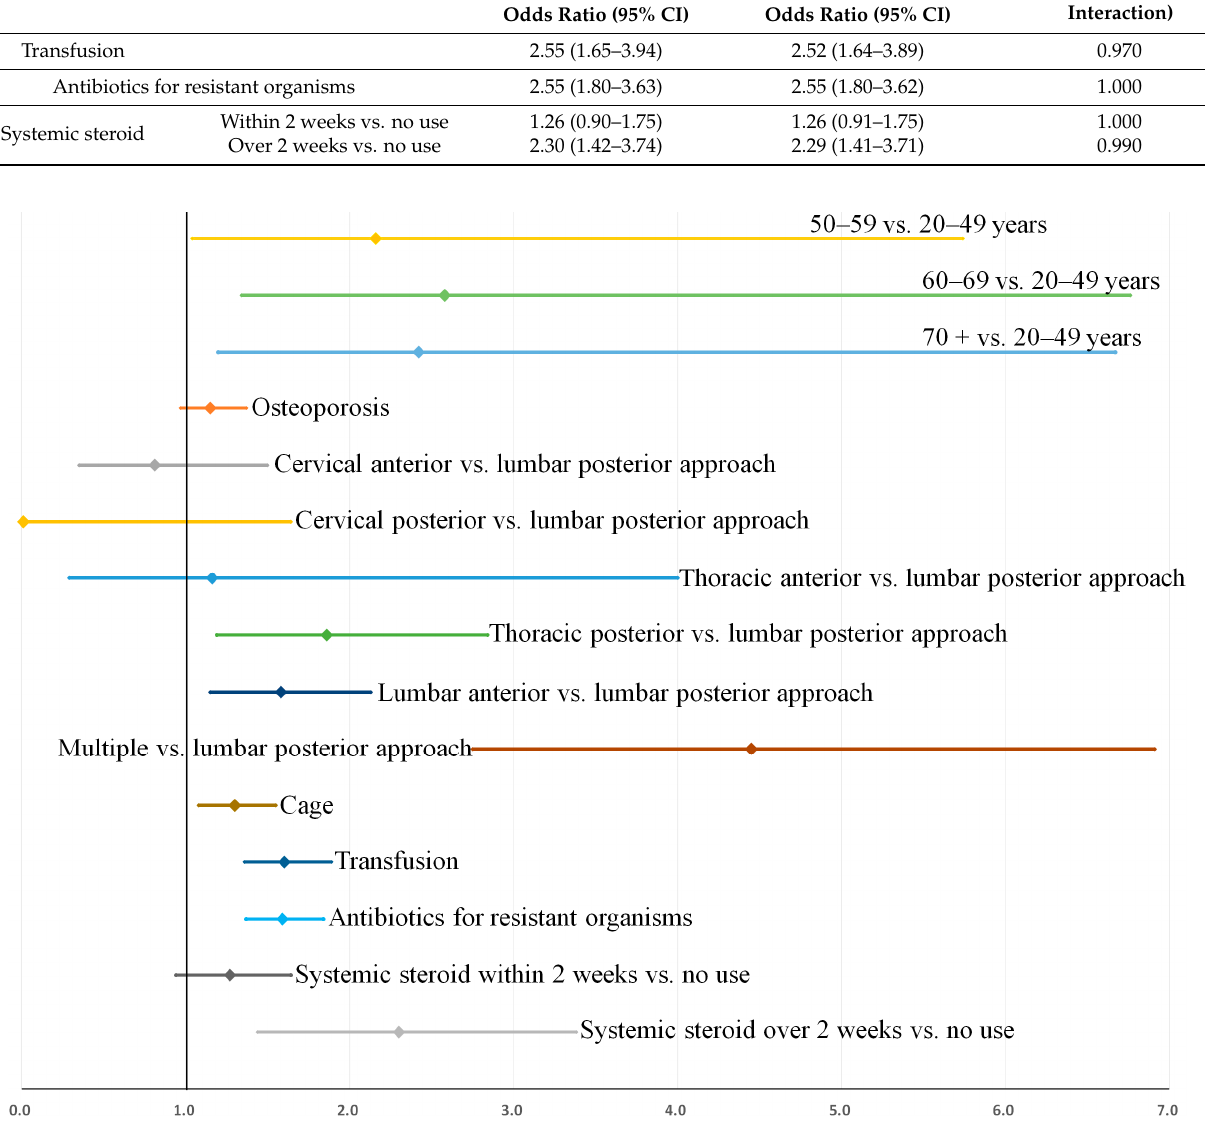
Figure 6. Factors associated with recurrence when recurrence was defined as an infection requiring over 2 weeks of antibiotic treatment: Bootstrap-adjusted odds ratios and their 95% confidence interval (Supplementary Table S6).